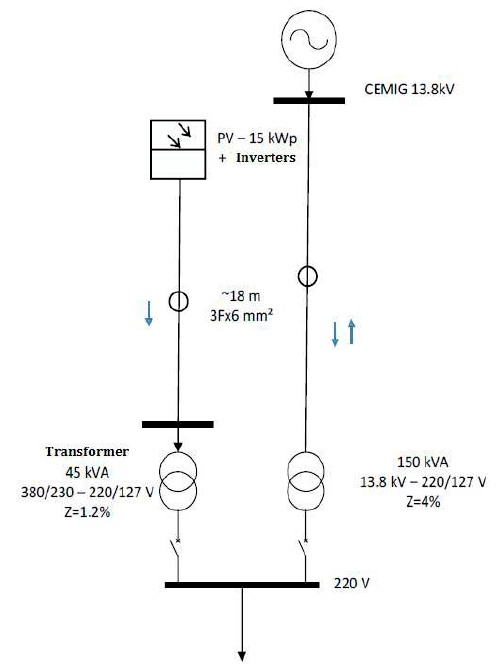
Figure 3. One-line diagram for the PV System of the CERIn sited in UNIFEI’s (Federal University of Itajub á )